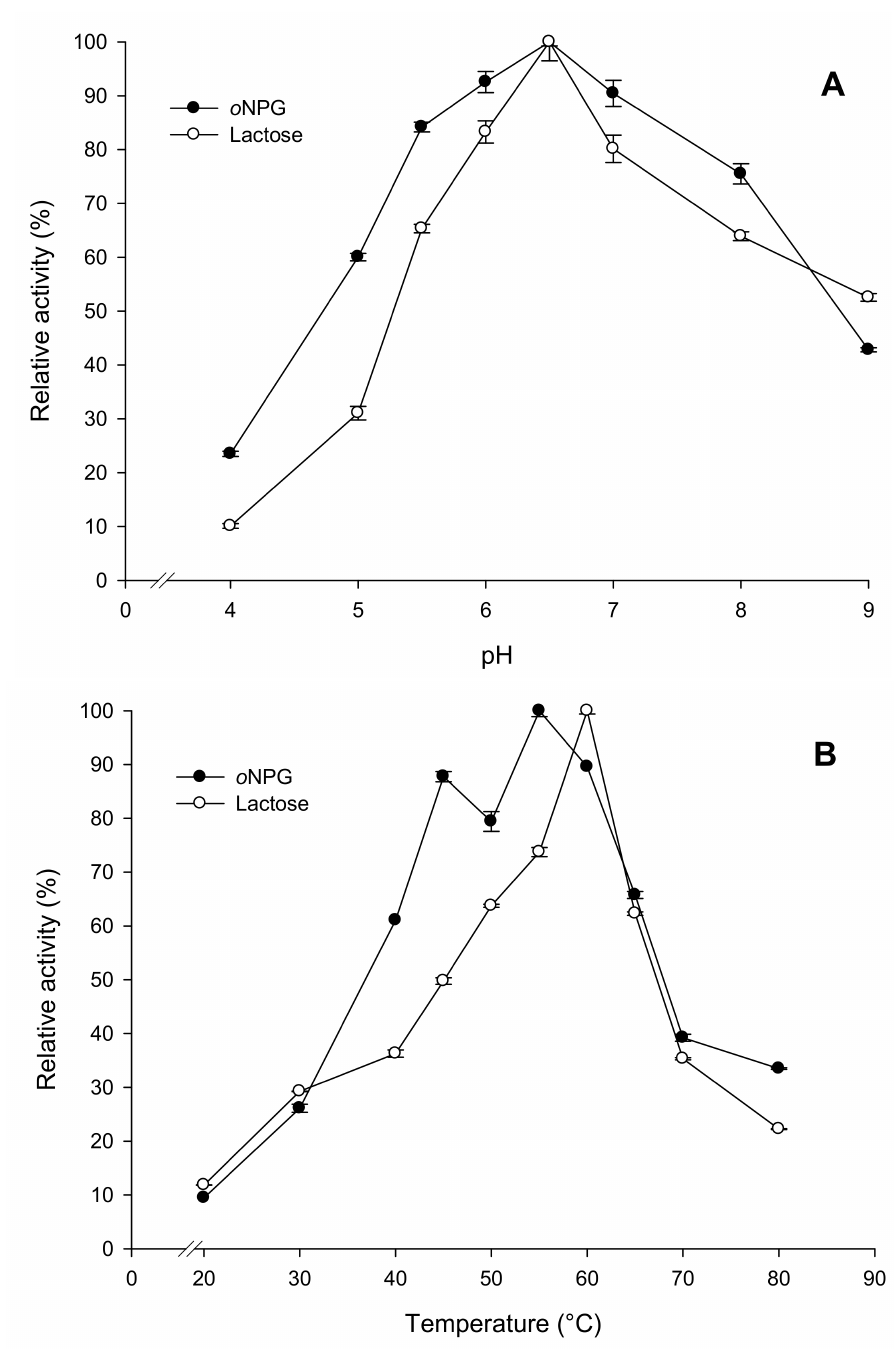
Figure 4. pH optimum ( A ) and temperature optimum ( B ) of recombinant β -galactosidase EcoliBL21Lh β -gal using o NPG and lactose as the substrates. Relative activities are given in comparison to the maximum activities measured under optimal conditions (100%). All data points represent the average value from two independent experiments, and the percentage error was always less than